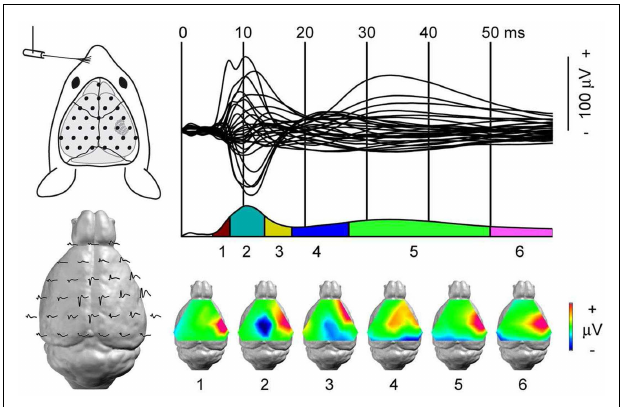
FIGURE 6 | Dynamic of somato-sensory network mapped with high-density EEG . Somato-sensory evoked potential (SEP) from left whisker stimulation. Top left: each black dot represents the position of one recording electrode; the most anterior one is ground. Top right: 31 electrode traces displaying the SEP with sub-milliseconds resolution. Bottom left: the same electrode traces represented over the mouse brain. In the lissencephalic mouse brain, dipoles are estimated to be generated below the recording electrodes. Bottom right: s egmentation of the SEP in six stable configurations of potential maps.The technique’s high spatial and temporal resolutions identify the first component, somato-sensory barrel field activity, followed by motor cortex and contra-lateral somato-sensory areas recruitment within a few milliseconds. Adapted from Megevand et al. (243) with